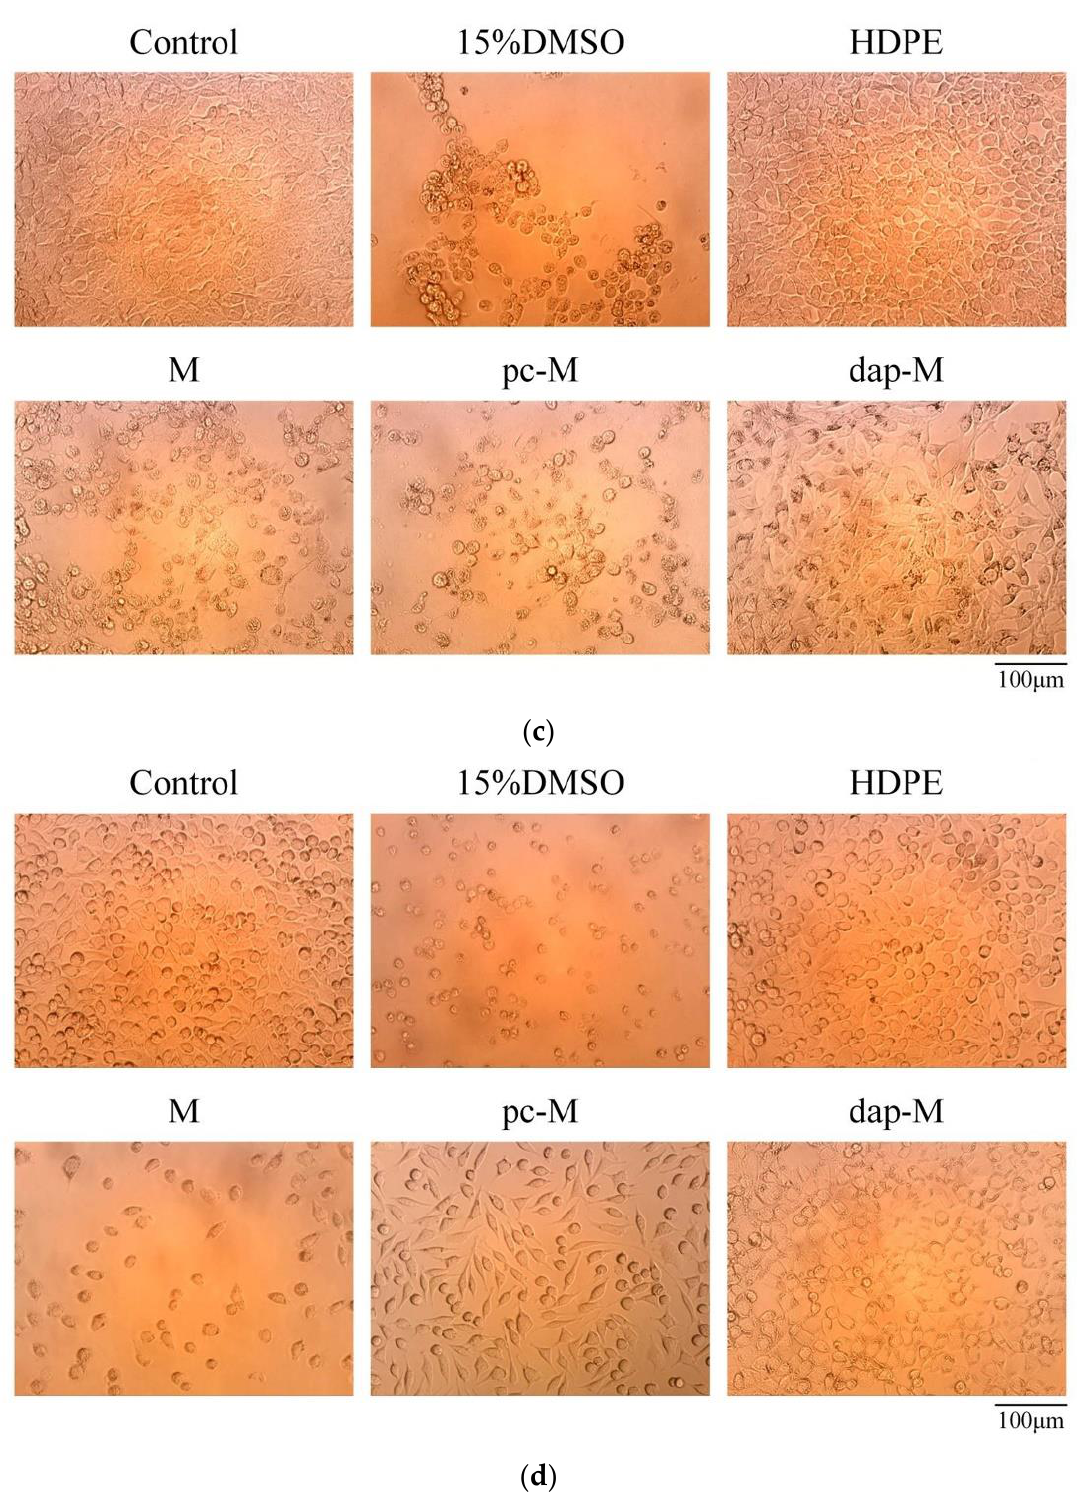
Figure 1. Cytotoxicity of gelatin-based microspheres modified with 5% PC (pc-M) and 1% DAP (dap-M): quantifications of ( a ) 3T3 and ( b ) L929 ( n = 3) and qualitative observation of ( c ) 3T3 and ( d ) L929 cell lines.